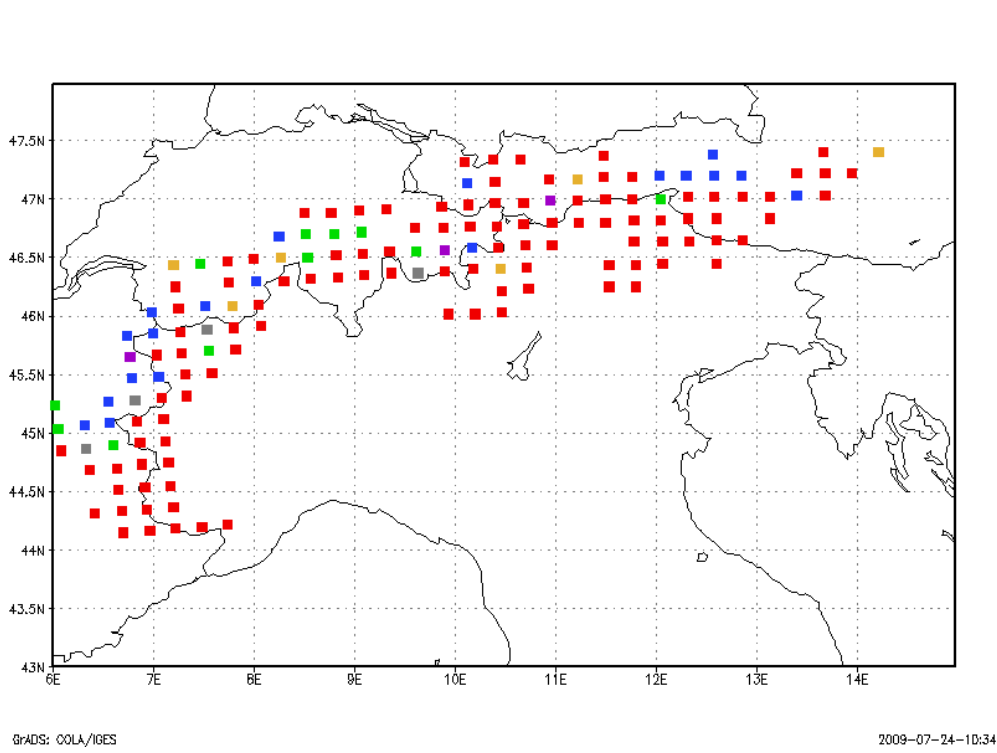
Figure 5. Geographical distribution of simulation points characterised by trend lines as described in Table 1 (that same table can also be referenced as a legend for the colors used in this